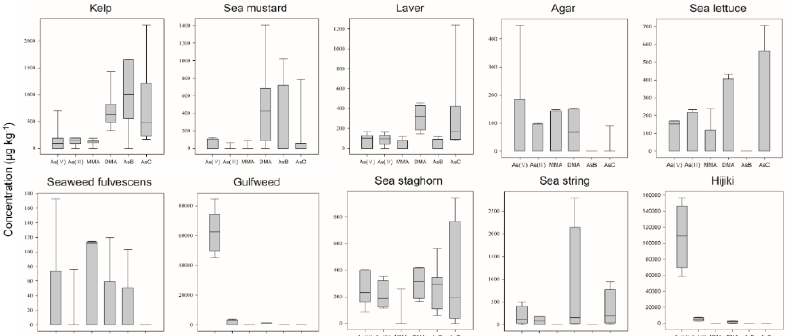
Figure 1. Boxplots of the distribution of 6 arsenic species in each seaweed species. Distribution of six arsenic species in kelp (n = 32), sea mustard (n = 25), laver (n = 25), agar (n = 20), sea lettuce (n = 20), seaweed fulvescens (n = 17), gulfweed (n = 12), sea staghorn (n = 13), sea string (n = 8), and hijiki (n = 8).